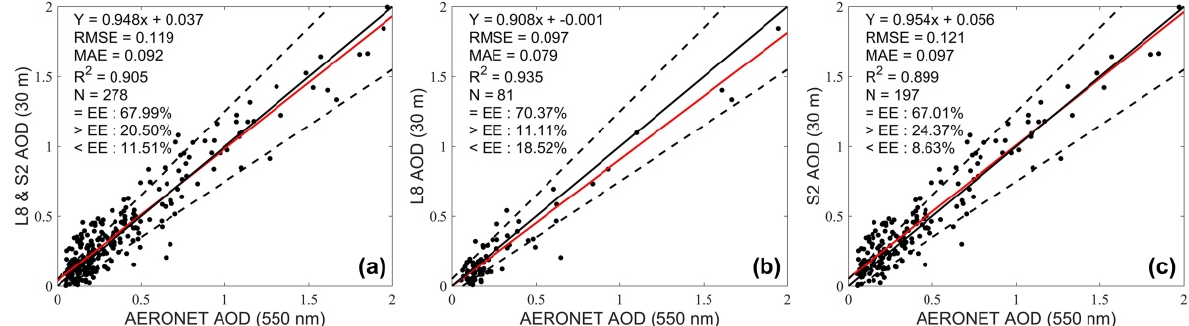
Figure 5. The validation of the AOD retrievals for ( a ) all three sensors, ( b ) Landsat-8, and ( c ) Sentinel-2 A/B. The solid black lines are a 1:1 line, the solid red lines are regression lines, and the dotted black lines are expected error (EE) lines, defined as ±(0.05 + 0.2 × AOD sunphotometer ).